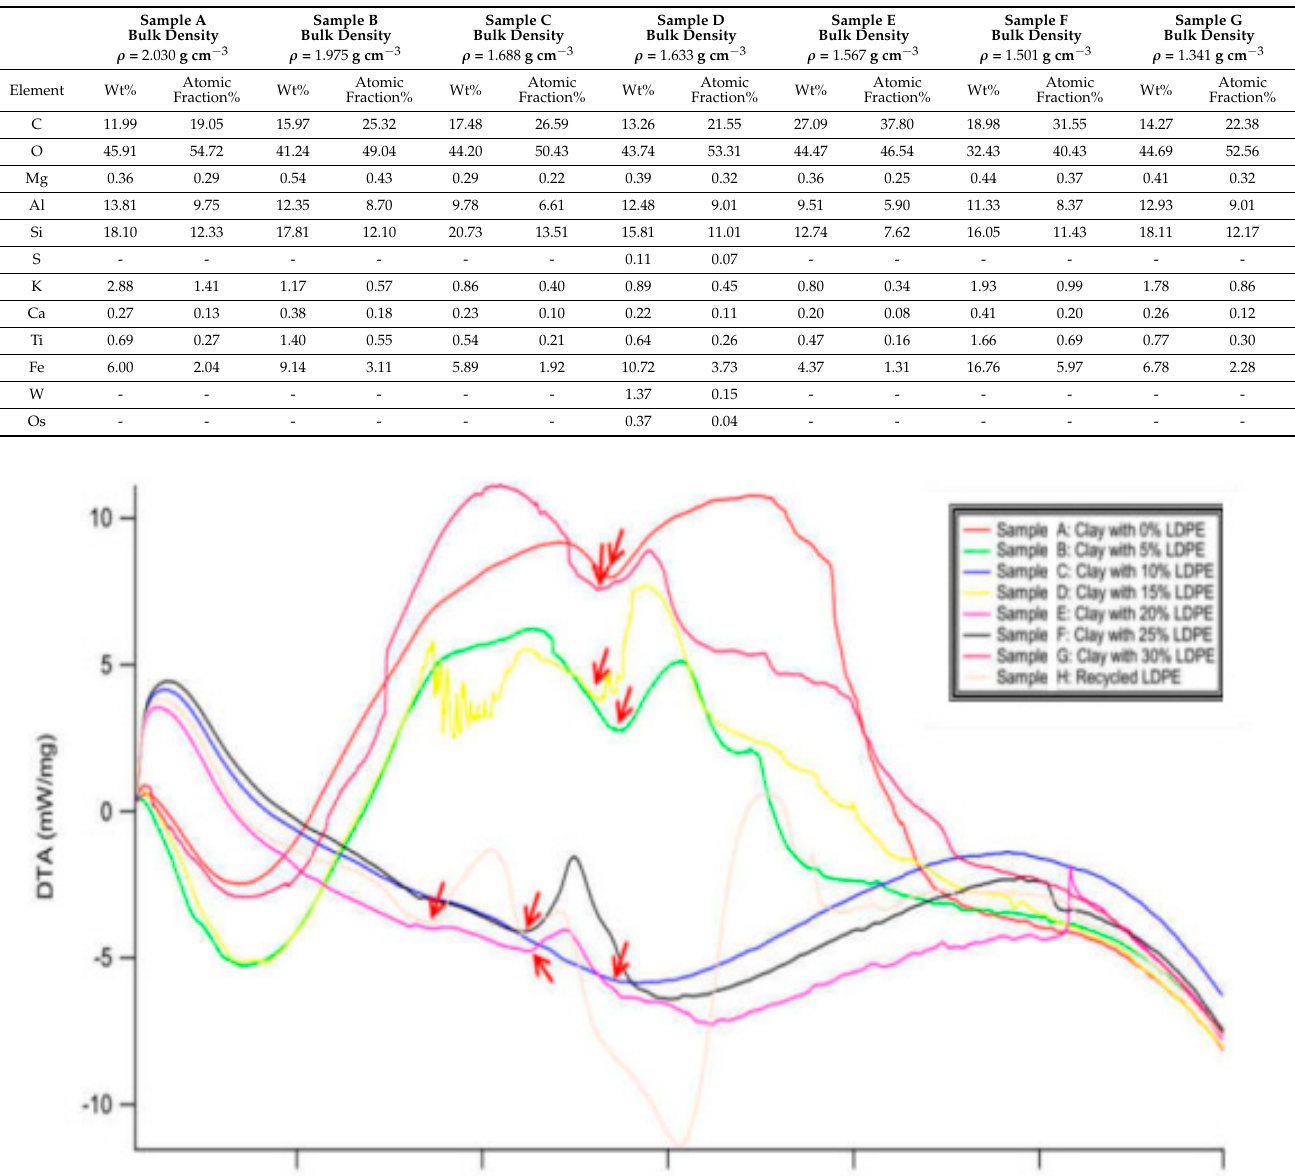
Table 3. EDX elemental composition of the sample in weight percent and in atomic fraction percent. SampleA BulkDensity